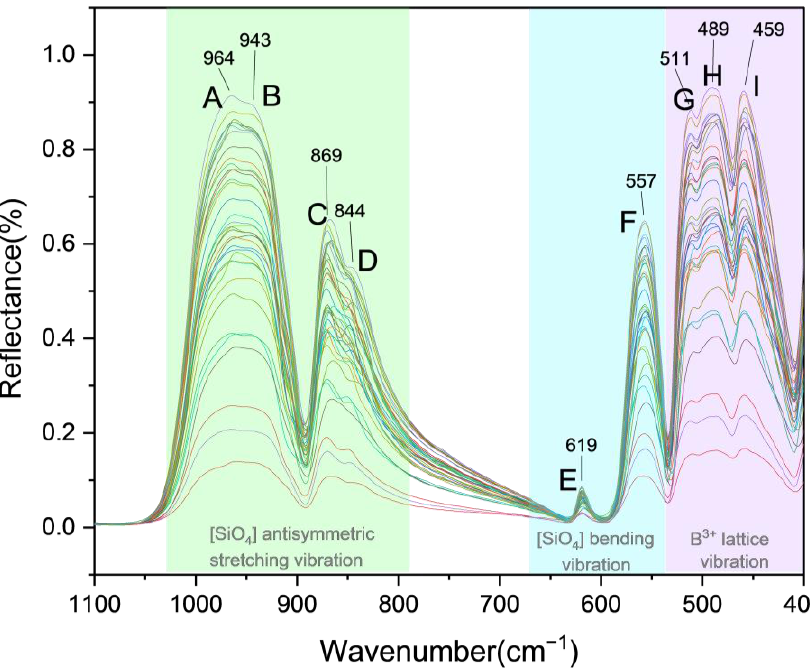
Figure 8. Infrared spectrum of 35 tsavorites.